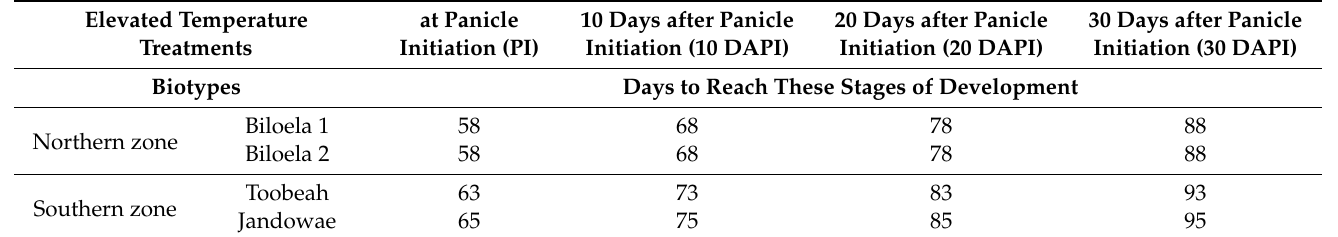
Table 1. The four times when Avena sterilis ssp. ludoviciana plant batches were moved from the ambi- ent temperature greenhouse (23/12 ± 2 ◦ C day/night temperature) to the temperature-controlled glasshouse (29/23 ± 2 ◦ C day/night temperature) to expose them to the elevated